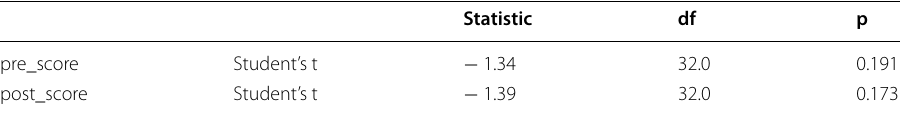
Table 6 Independent samples T‑test